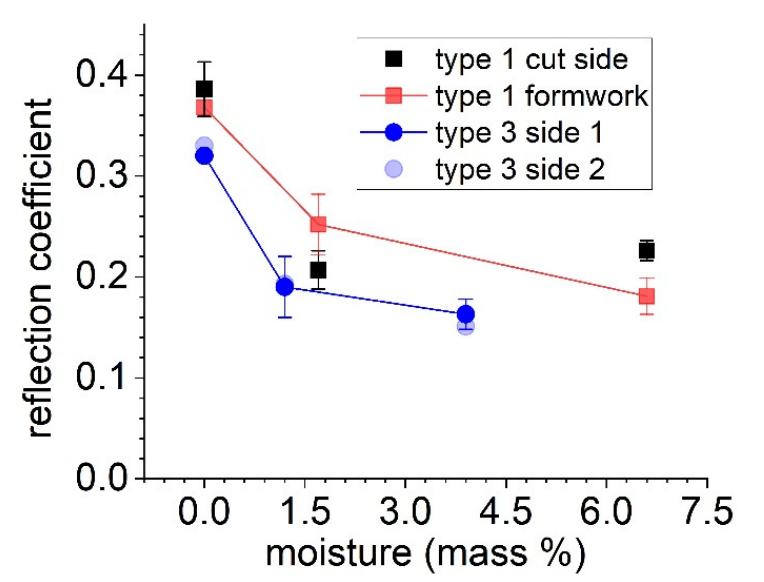
Figure 16. Reflection coefficient at 940 nm measured on sample surfaces with different moisture contents. The error bars result from multiple measurements in different surface regions.